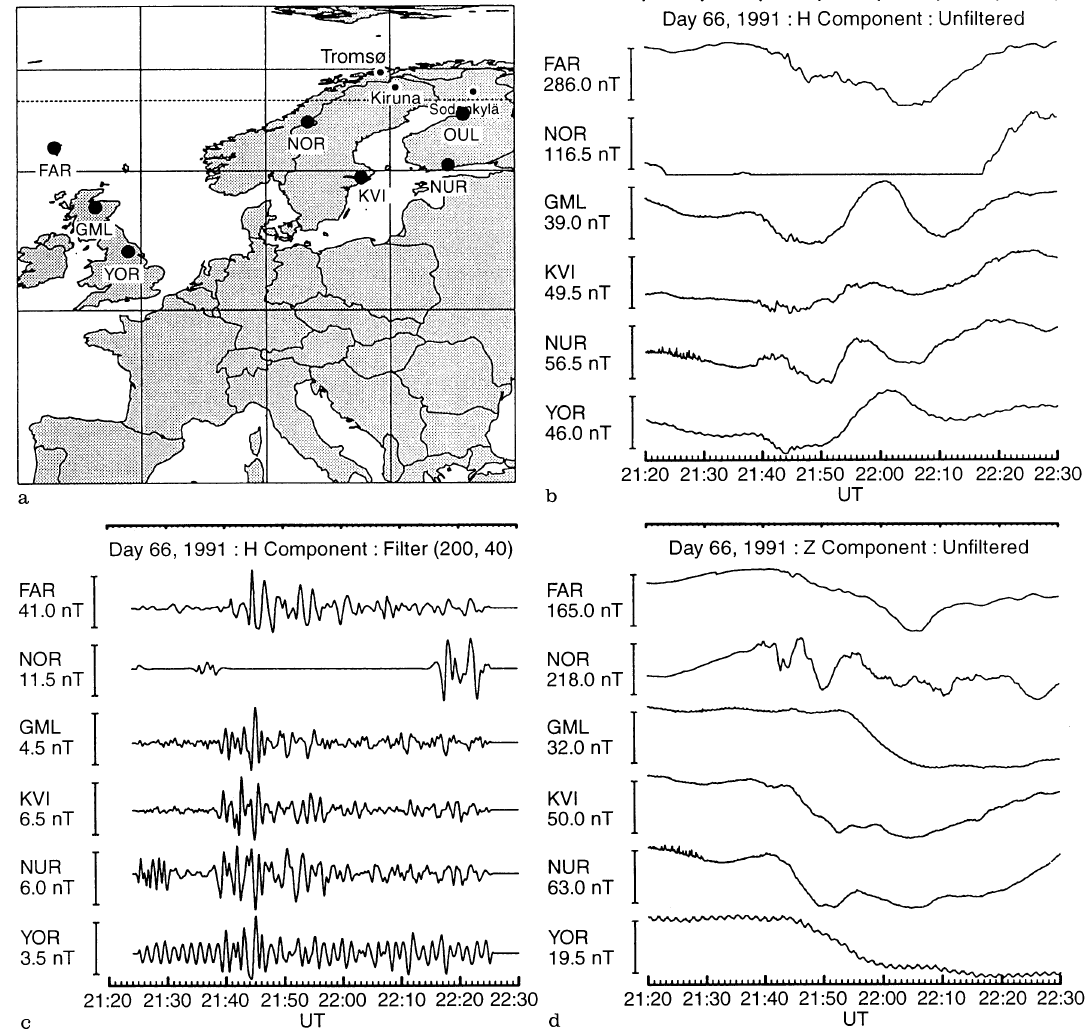
22 (cid:49)(cid:48) UT; c SAMNET H components filtered to show Pi2 pulsa- tions; d Magnetic Z components observed by SAMNET stations